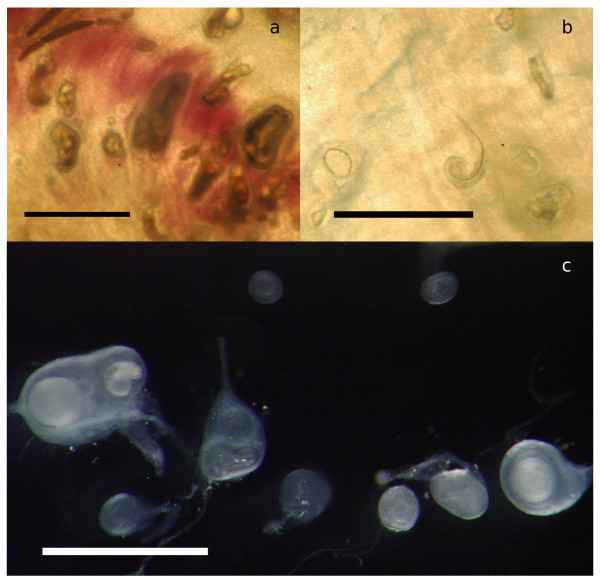
Encapsulated larvae of A. crassus in the intestinal and swimbladder-wall of Japanese eels. Encapsulated larvae of A. crassus from the swimbladder wall (a) and the intestinal wall (b and c). Pictures a and b are taken from unfixed tissue during dissection using transmitted light under a stereo microscope. Picture c is taken during preparation of intestinal capsules for PCR from fixed tissue using incident light. Scales indicate 1 mm.